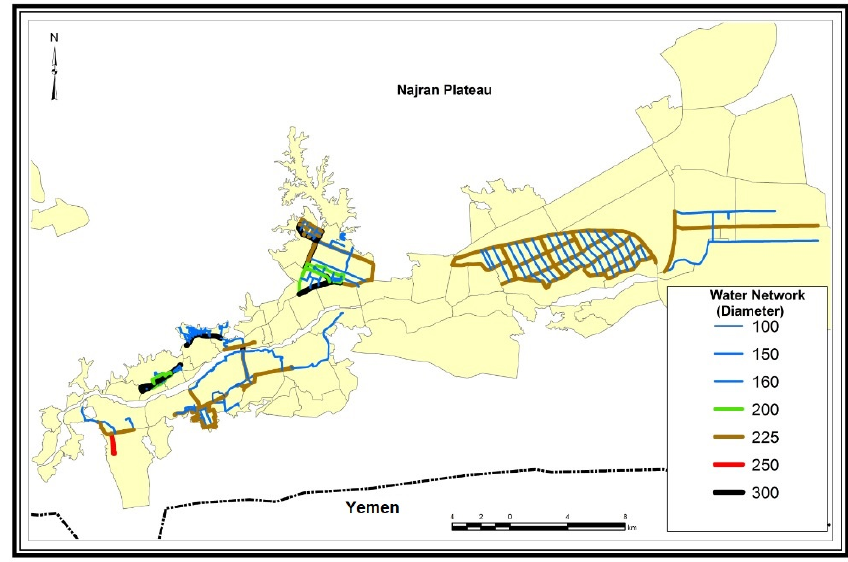
Figure 5. Water distribution network in the city of Najran (pipe diameters are in mm.).